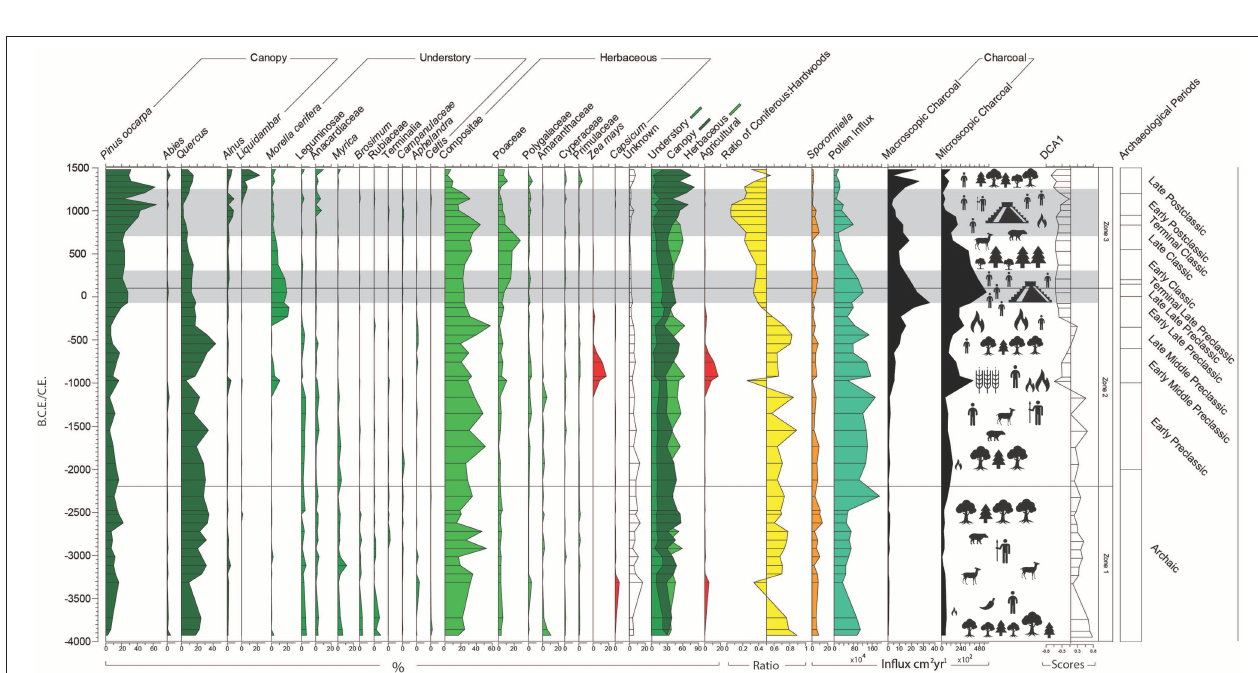
FIGURE 5 | Palynological percentage diagram of taxa appearing in an abundance > 2%; forest structure; coniferous to hardwood ratio; pollen influx; macroscopic and microscopic influx; DCA axis 1; and Occupation of Chinkultic (dark bands). The palynological data are expressed as a percentage of total land pollen.